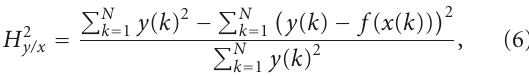
Figure 1: Example of the deformation process of a time-frequency snake obtained on a synthetic signal (SNR 10dB) with 100 itera- tions. Intermediate snakes are displayed for di ff erent iteration time ( T x ), where x represents the number of iterations. T 0 represents the initial snake and T 100 the final extracted